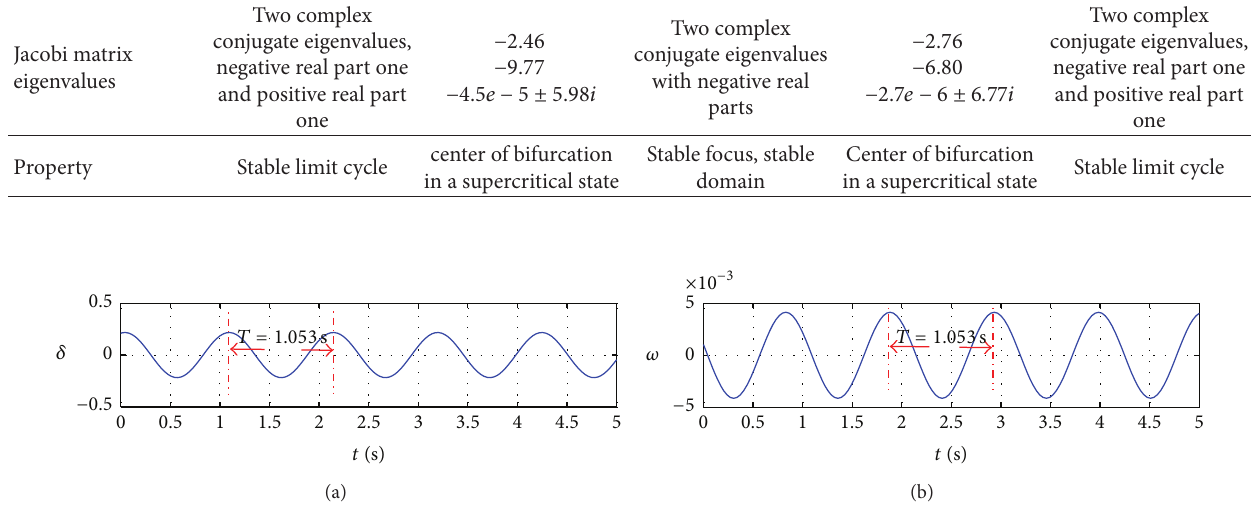
Figure 5: Time waveforms of 𝛿 and 𝜔 with 𝐾 𝑖 = 1 , 𝐾 𝑝 = 2 , and 𝐾 𝑑 = 0.309